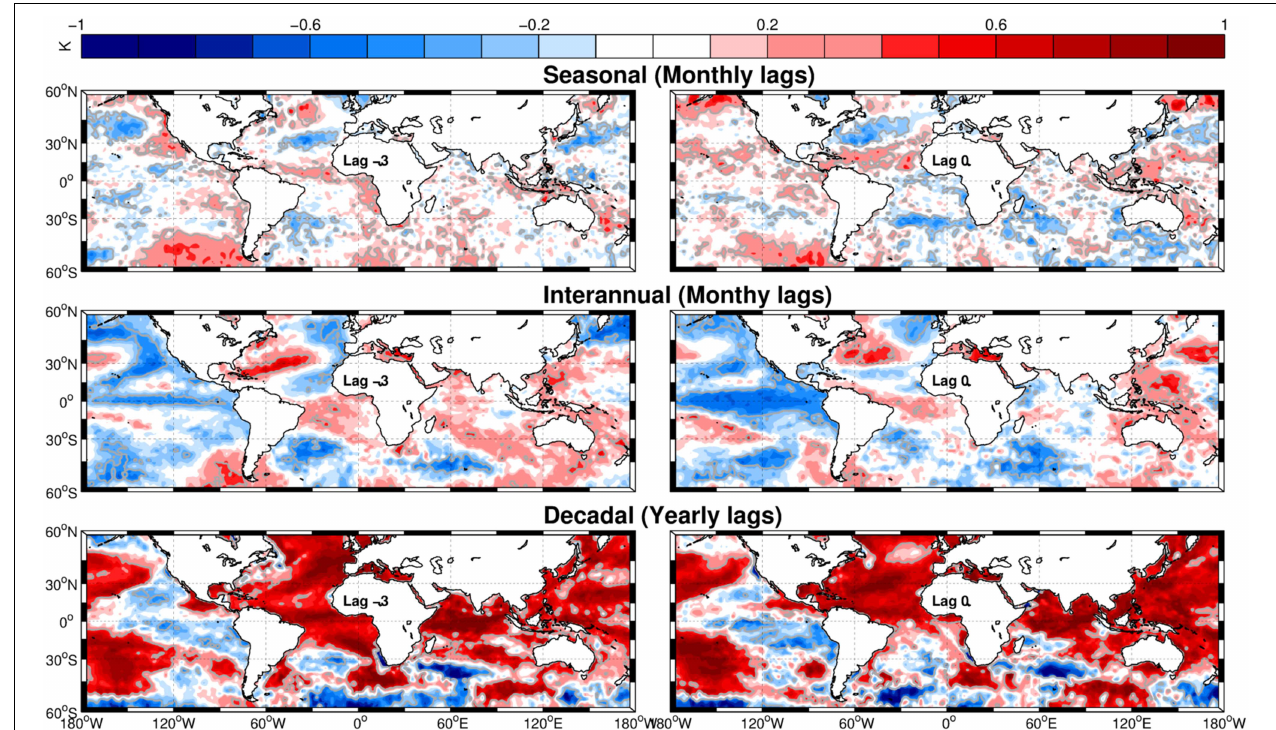
FIGURE 8 | Lagged regression maps at different time scales of Saloum rainfall index and SST during summer (JAS). Units of the color scale are K. Contours show area where regressions are statistically significant at the 95% level using a Monte Carlo simulation.